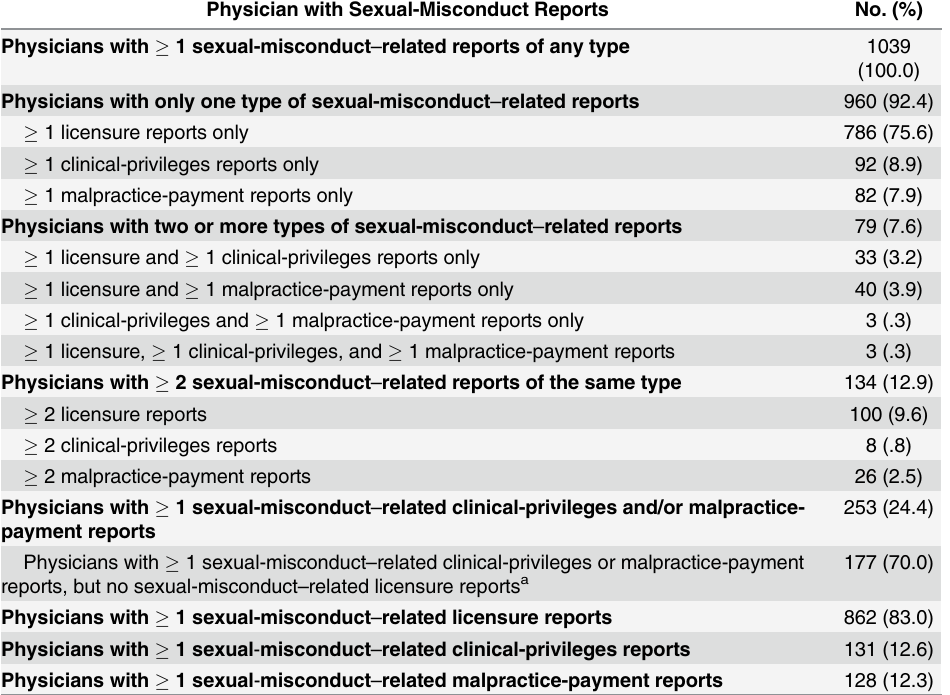
Table 1. Physicians With Sexual-Misconduct – Related NPDB Reports, 2003 – 2013 (Physician-Level